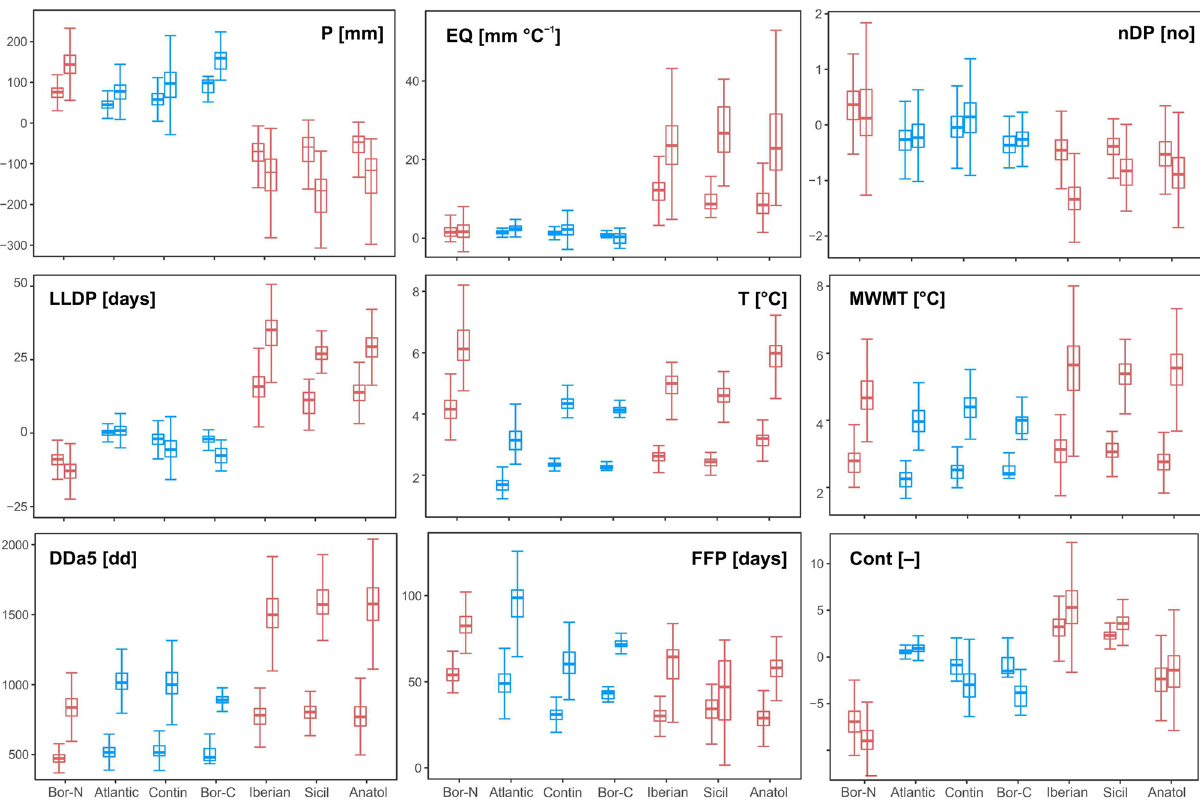
Figure 2. Predicted change in nine climatic variables in the geographical subzones predicted to have high or low future climatic stability (numbering of zones corresponds with Fig. 1). Boxplot pairs show projected changes driven by RCP4.5 (left) and RCP8.5 (right) and indicate their variation within each subzone. Colours indicate subzones with predicted low (red) and high (blue) climate stability. Variable acronyms: P annual total precipitation [mm], EQ Ellenberg climatic quotient [°C mm −1 ], nDP number of dry periods [no], LLDP length of the longest dry period [days], T annual mean temperature [°C], MWMT mean warmest month temperature [°C], DDa5 degree-days above 5 °C [dd], FFP longest frost-free period [days], Cont Gorczynski climatic continentality [–]. The graphs were created in R v. 4.0.4. 26 .